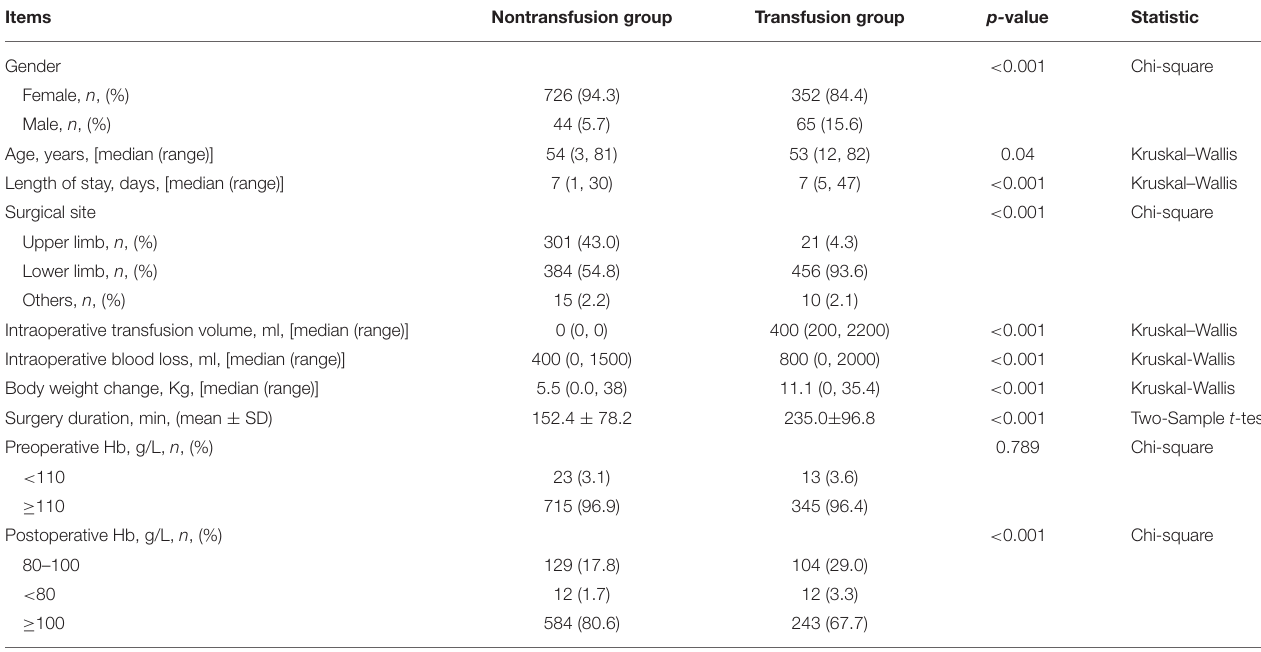
TABLE 1 | Summary of patients’ demographic and clinical